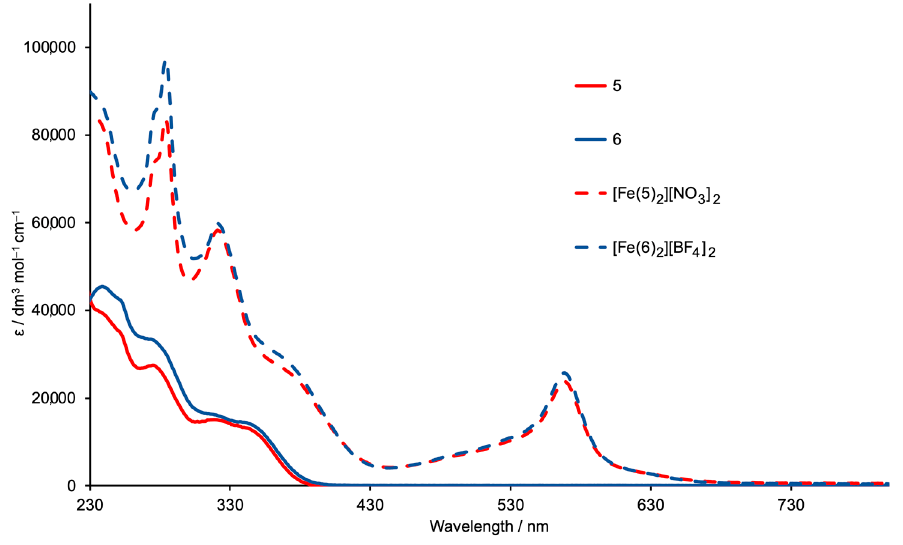
Figure 8. Absorption spectra of ligands 5 (MeCN/CHCl 3 , see text) and 6 (MeCN, 2.0 × 10 − 5 mol dm − 3 ),